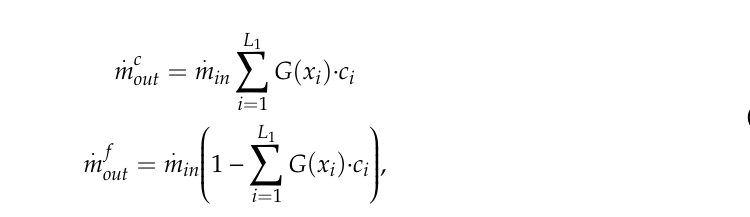
Table 1. Model parameters used for the agglomeration process.